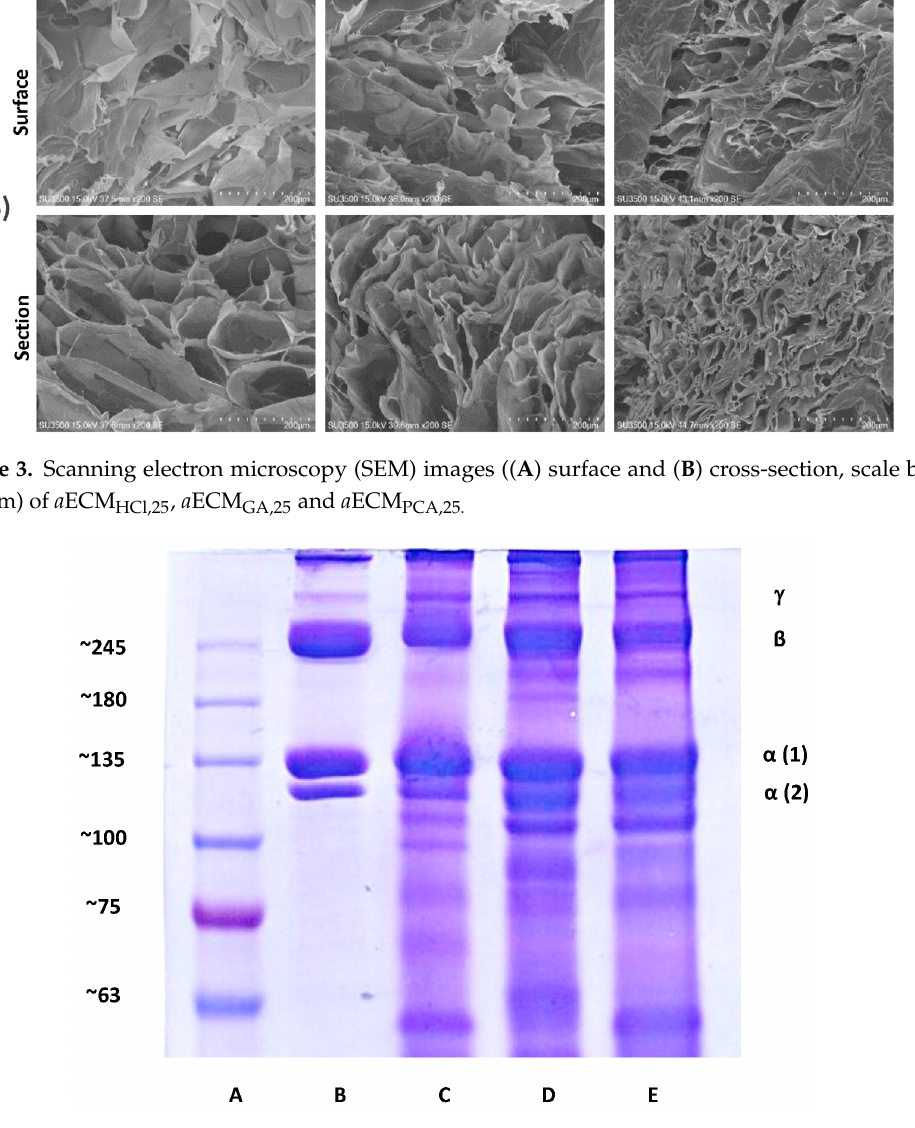
Figure 4. Sodium dodecylsulfate-polyacrylamide gel electrophoresis (SDS-PAGE) electrophoresis patterns. ( A ) Marker, ( B ) porcine type I collagen standard, ( C ) a ECM HCl,25 hydrogel, ( D ) a ECM GA,25 hydrogel and ( E ) a ECM PCA,25